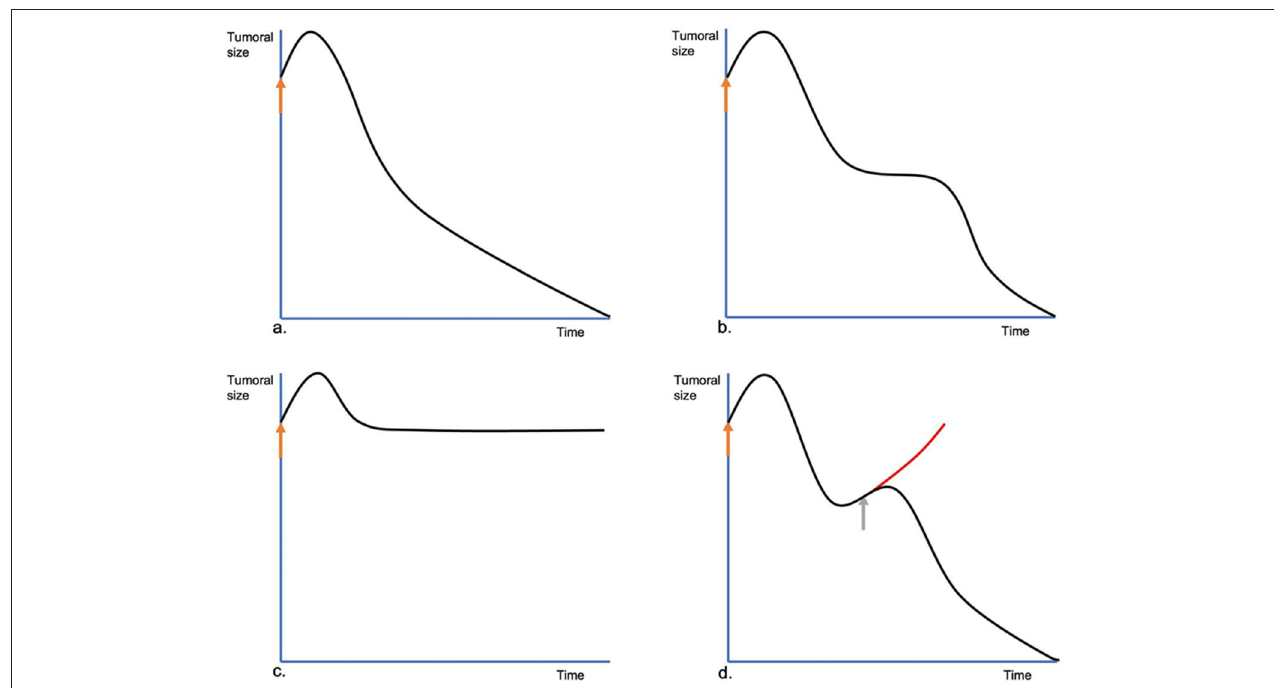
FIGURE 7 | Different evolutions of the tumors treated by ECT. In (a) , the common evolution. At first, immediately after the ECT session (orange arrow), the treated lesion swells, increasing its size, but on the following day, it starts to reduce steadily until its complete remission. In (b) , the two-times evolution. The lesion, after the initial swelling, starts shrinking, but it stops. The lesion remains steady for some time and then resumes shrinking until its final response. In (c) , the no-change evolution. After the initial swelling, the tumor shrinks to its pretreatment size, without shrinking any more, or shrinking very slowly. In (d) , the tumoral escape evolution. After the initial response, the tumor starts growing again. A new ECT session should be performed as soon as possible (gray arrow) to prevent a